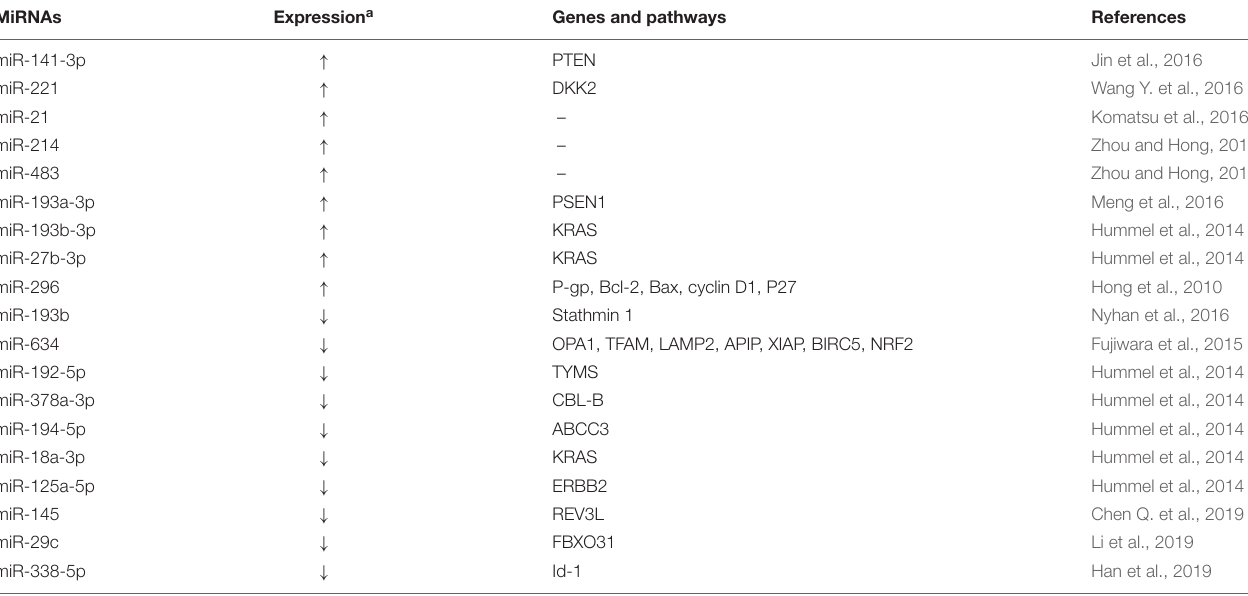
TABLE 2 | MicroRNAs (miRNAs) and 5-FU resistance in esophageal cancer. MiRNAs Expression a Genes and pathways